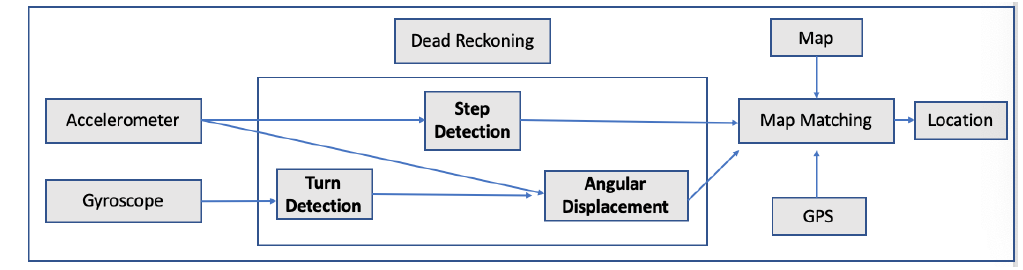
Figure 7. APTS’s flow chart in Reference [48].